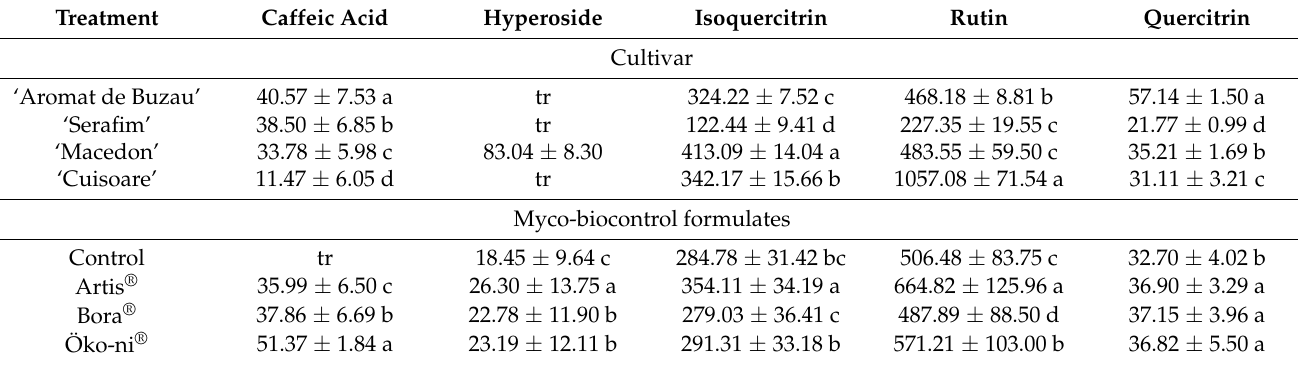
Table 3. Influence of cultivar and myco-biocontrol formulates on phenolic compounds of basil.